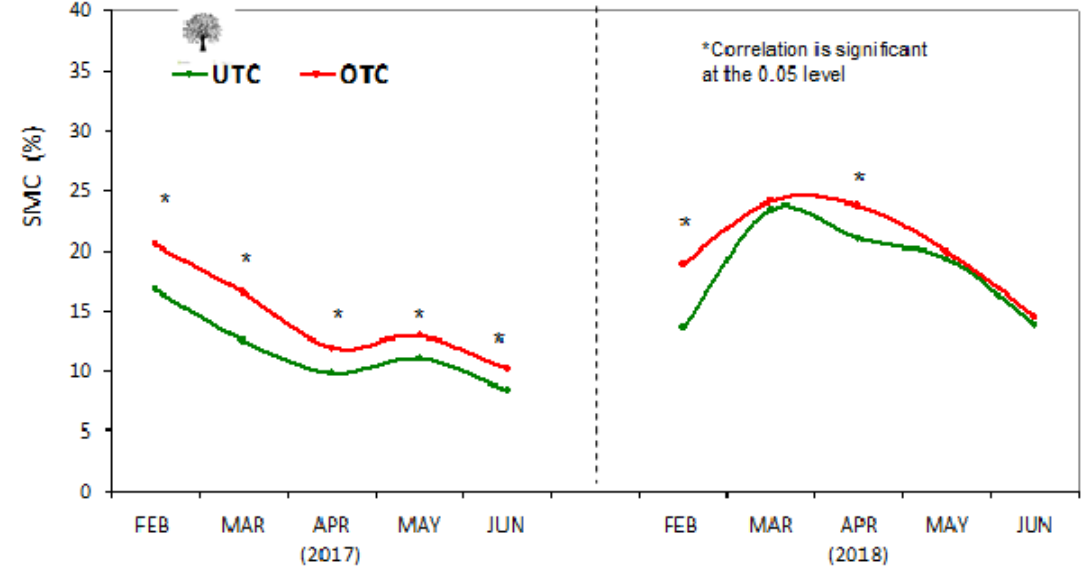
Figure 9. Monthly soil moisture content (SMC) under tree canopy (UTC) and outside tree canopy (OTC) between March and June of 2017 and 2018. *—Correlation is significant at the 0.05 level.